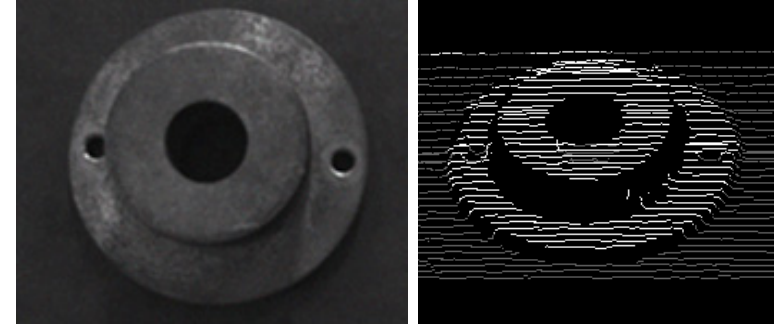
Figure 13. 3D range measurement of a cylindrical object with